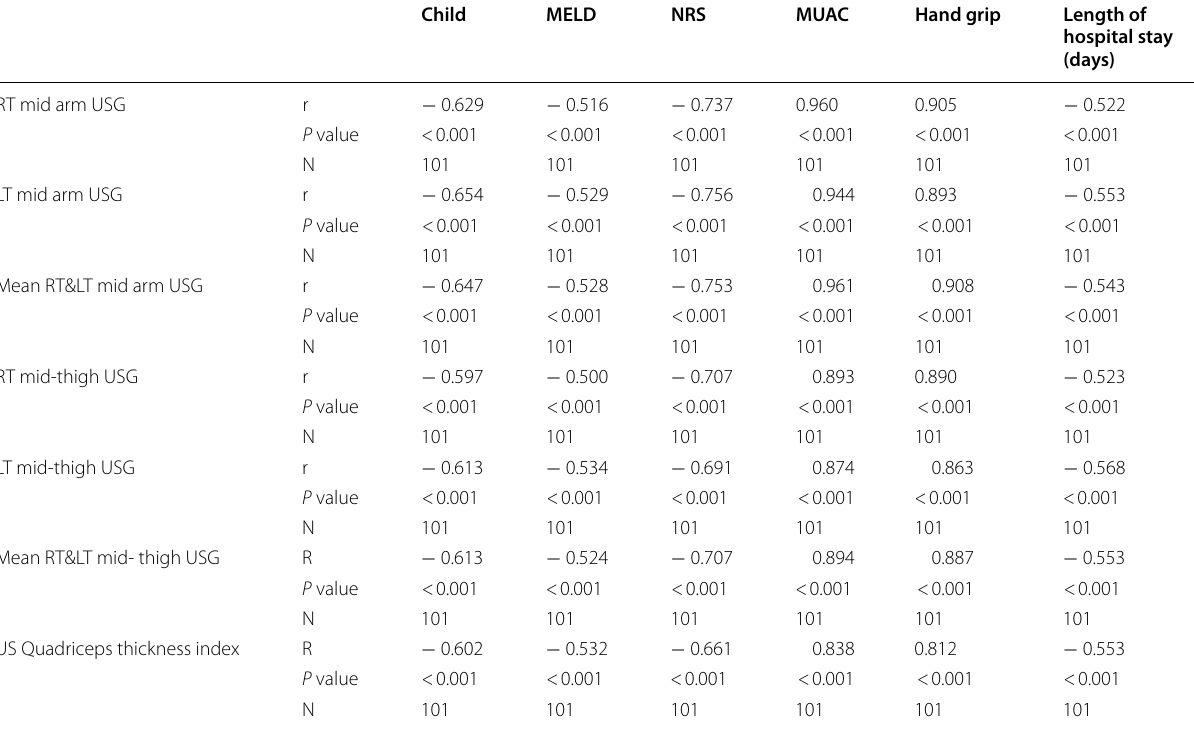
Table 7 Correlation between ultrasound parameters, (Child, MELD, and NRS) scores, hand grip, and length of hospital